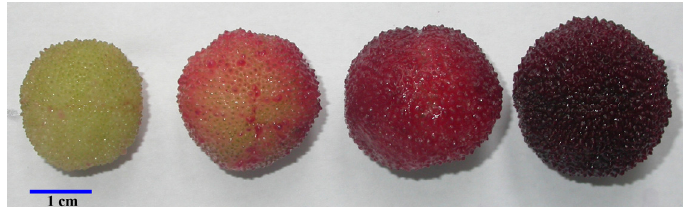
Figure 1. Size and color of “Biqi” fruit at mature green (MG), pink ripe (PR), red ripe (RR), and full ripe (FR) stages.